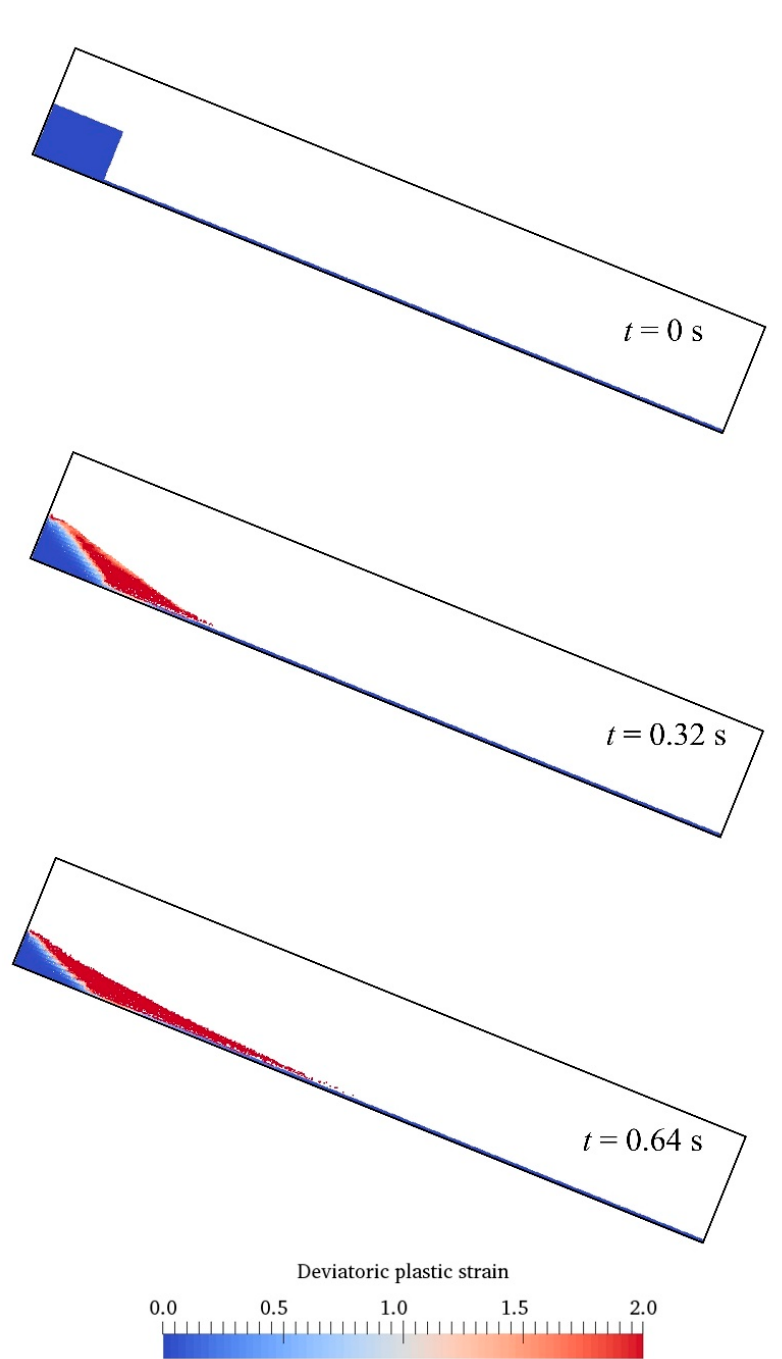
Figure 4. Snapshots for landslides sliding along erodible slopes.